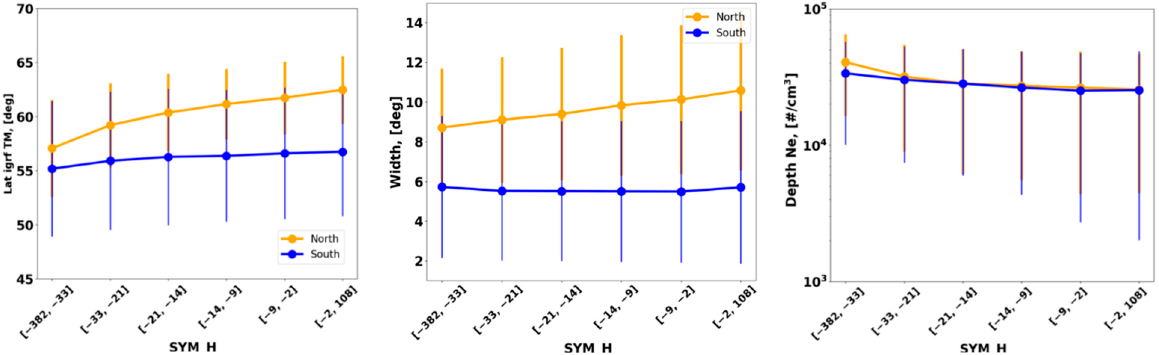
Figure 18. SYM-H index dependence of the trough minimum position, trough width, and depth for the northern and southern hemispheres.